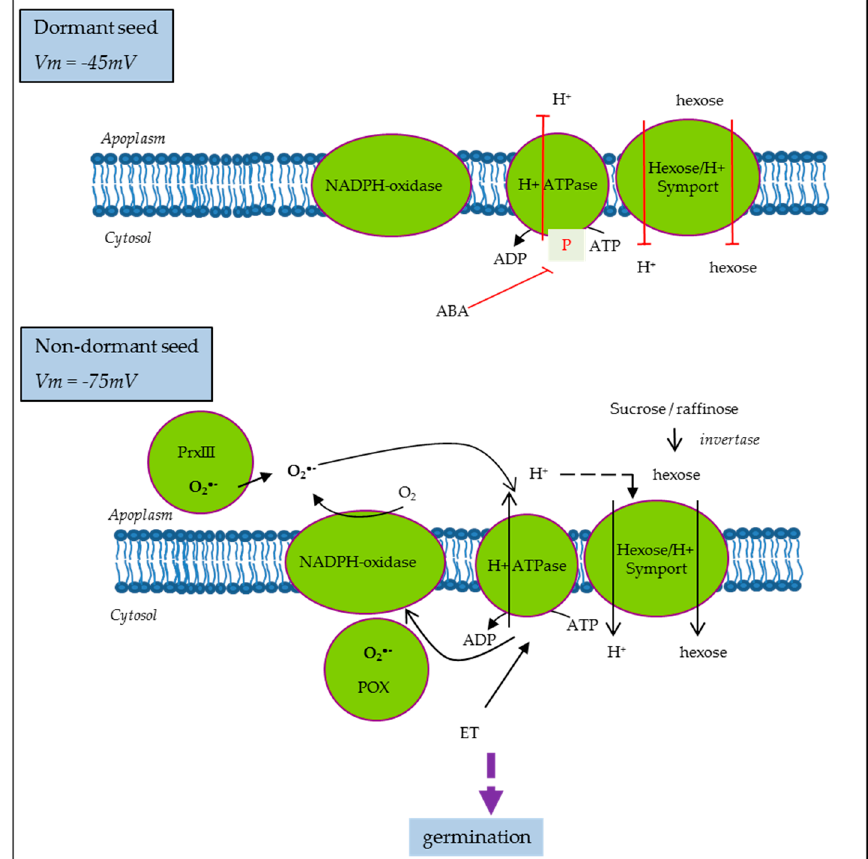
Figure 4. A model for seed cell polarization regulation in the control of dormancy in sunflower [52]. ABA, abscisic acid; PrxII, cell wall peroxidase III; POX, cytosolic peroxidase; ET, ethylene; Vm, PM potential.